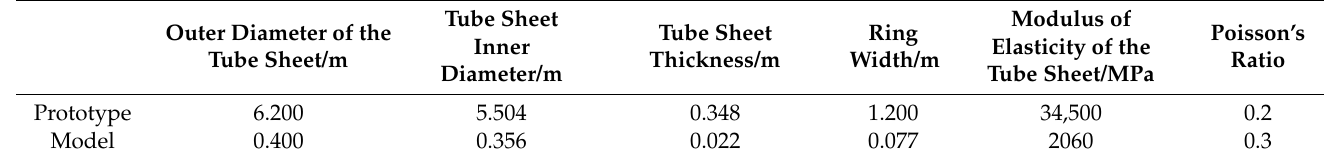
Table 3. Geometric parameters and material properties of the tunnel model .